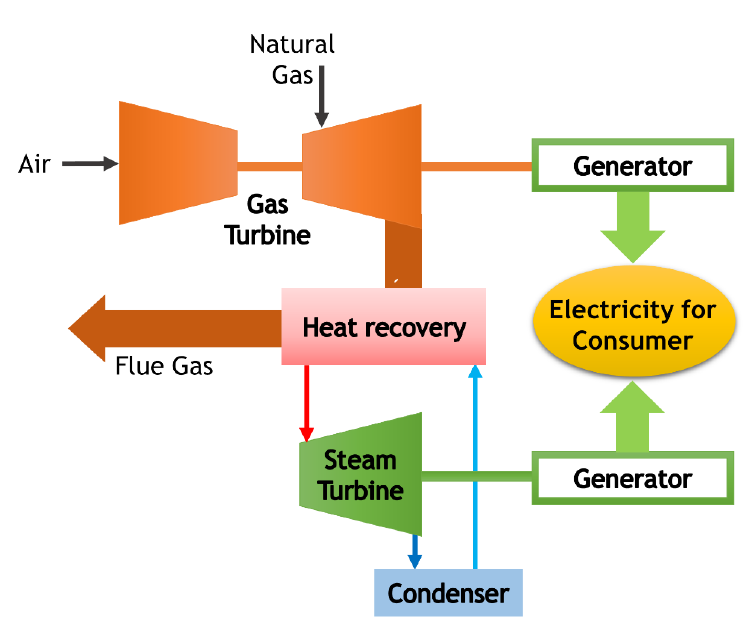
Figure 2. Schematic of the natural gas-fired combined cycle power plant (NGCC).